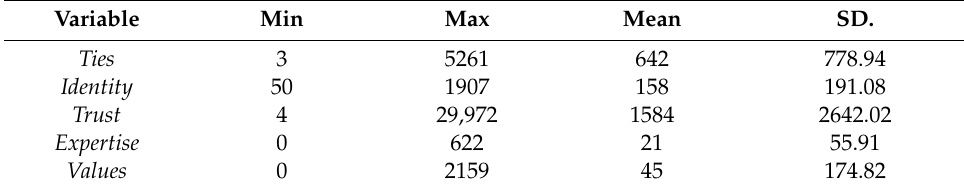
Table 2. Descriptive statistics of the independent variables.